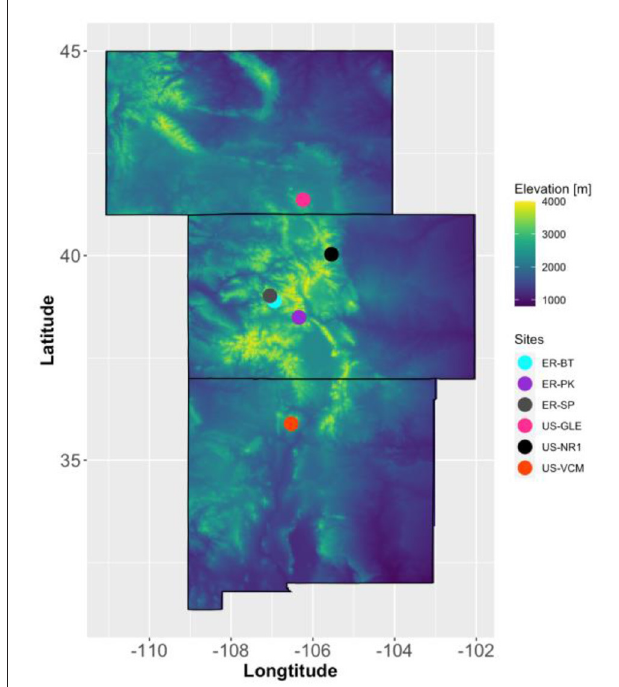
FIGURE 1 | Geographical locations of the six sites selected in this study. ER-BT, ER-PK, and ER-SP represent Butte, Porphyry Creek, and Scofield Pass SNOTEL stations. US-GLE, US-NR1, and US-VCM are the three FLUXNET sites considered in this